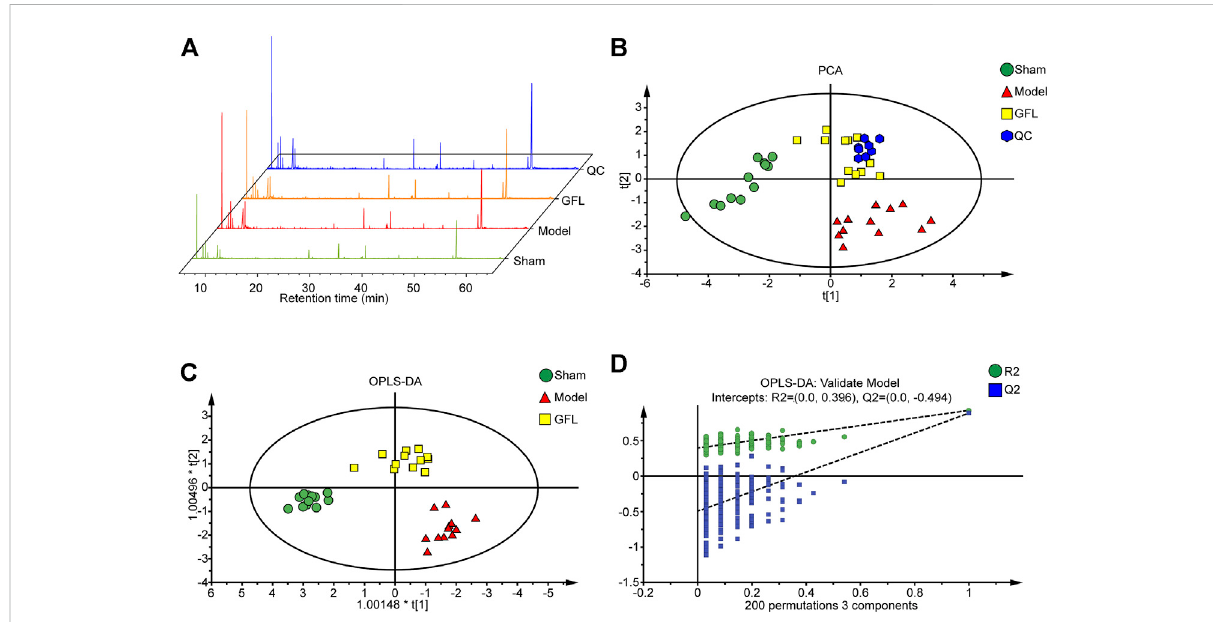
FIGURE 4 Metabolomic analysis of metabolic disorders in BDL mice by GFL. (A) TIC map of total ion currents of GC-MS metabolites in serum of mice in eachgroup. (B) PCAanalysisofserumGC-MSmetabolitesinmiceineachgroup. (C) AnalysisofserumGC-MSmetabolitesOPLS-DAofmiceineach group. (D) In total, 200 permutation tests were performed on the OPLS-DA